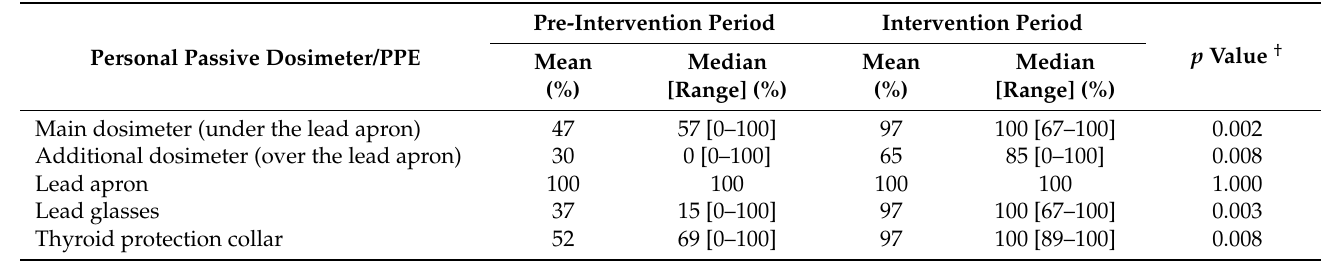
Table 4. Use rate of personal passive dosimeters and * PPE by physicians ( n = 14).